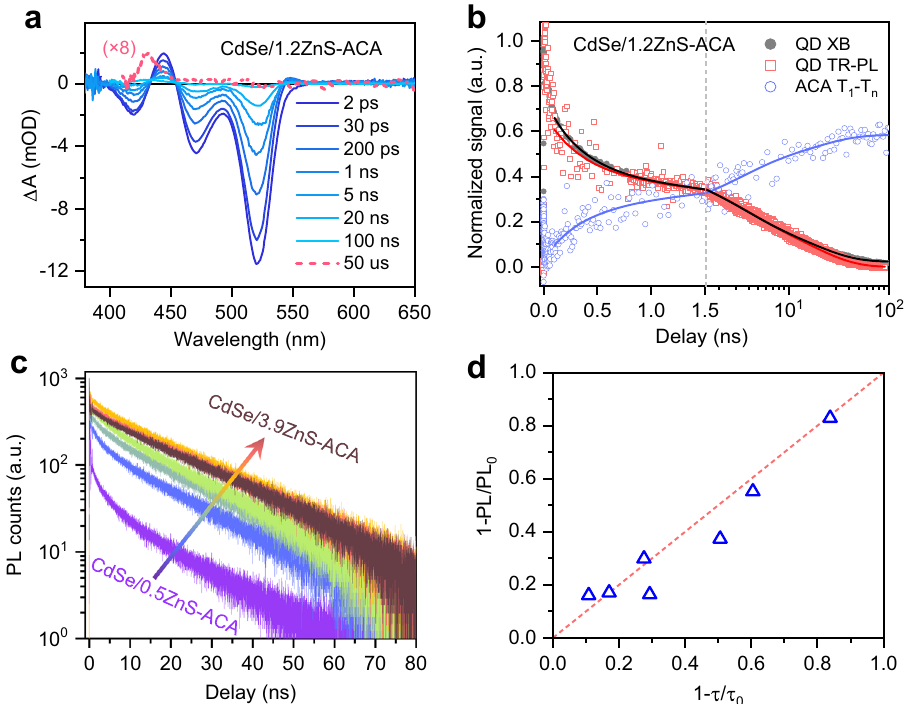
Fig. 3 TET in QD-ACA complexes. a Transient absorption (TA) spectra of CdSe/1.2ZnS QD-ACA complexes at indicated delays following 525 nm excitation. Spectrum at a delay of 50 μ s is ampli fi ed to show the absorption of sensitized ACA triplets. b Comparison of exciton bleach (XB; gray solid circles) and time-resolved photoluminescence (TR-PL; red open squares) kinetics of QDs and triplet absorption (open blue circles) of ACA molecules in CdSe/1.2ZnS QD-ACA complexes. The solid lines are multi-exponential fi ts to the data. c TR-PL kinetics of CdSe/ZnS QD-ACA complexes with increasing shell thicknesses (blue to red). d Correlation between steady-state (ordinate) and TR-PL (abscissa) quenching ef fi ciencies in QD-ACA complexes. The former and the latter are calculated from 1 − PL/PL 0 and 1 − τ / τ 0 , respectively, where PL 0 ( τ 0 ) and PL ( τ ) are the PL intensities (average lifetimes) of free QDs and QD-ACA complexes, respectively. The red dashed line is a linear scaling